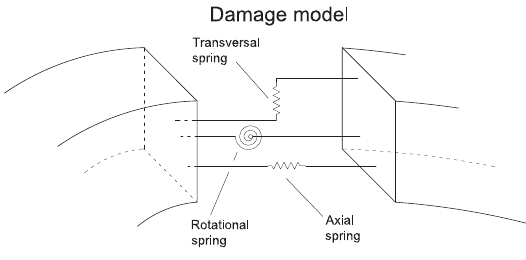
Figure 4: Schematic representation of the damage